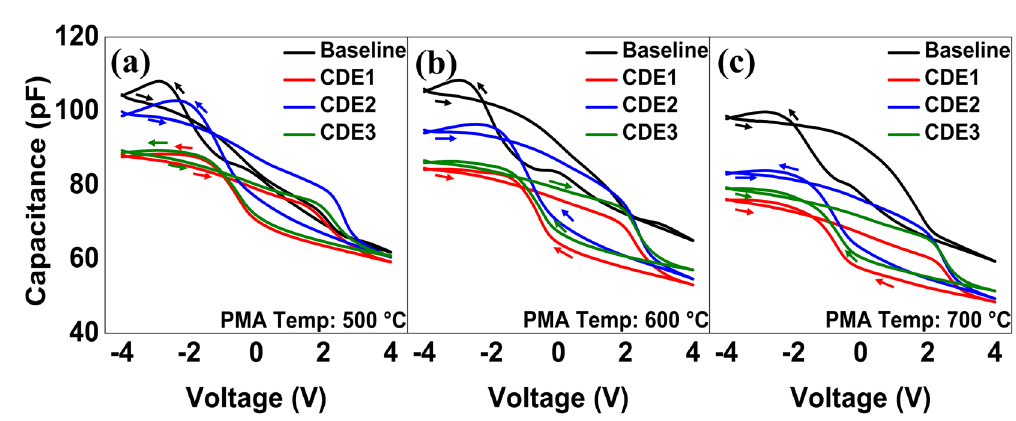
Figure 6. Measured capacitance- vs. -voltage of MFIS capacitors for three different PMA temperatures: ( a ) 500 °C, ( b ) 600 °C, and ( c ) 700